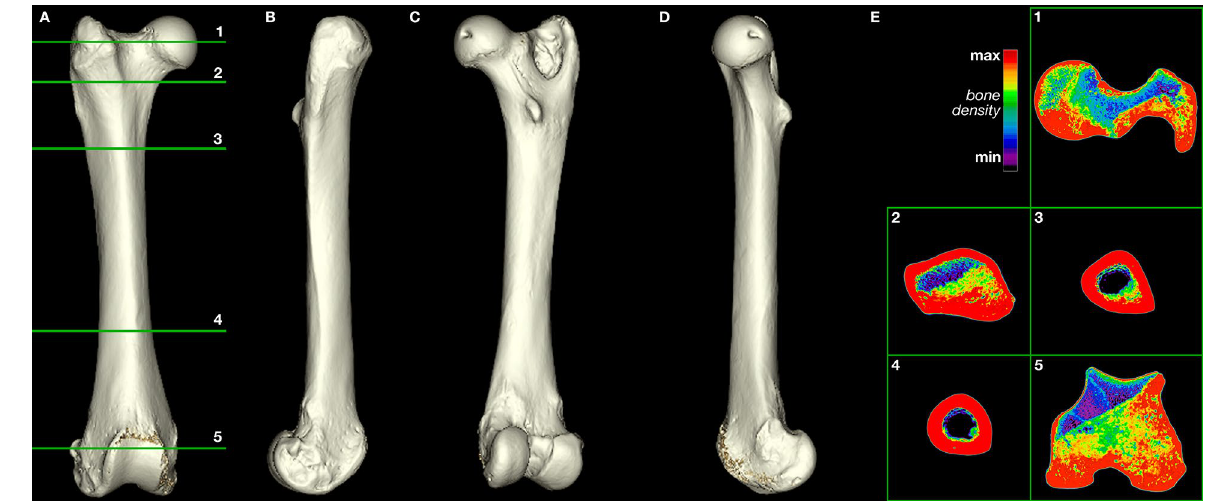
Figure 5. Three-dimensional model of a normal Smilodon right femur (LACMHC K-3232). Horizontal numbered lines in ( A ) mark anatomical location of numbered CT slices displayed in ( E ). ( A ) Anterior view of right femur; ( B ) rotated 90 degrees from anterior about the vertical axis (lateral view); ( C ) rotated 180 degrees from anterior about the vertical axis (posterior view); ( D ) rotated 270 degrees from anterior about the vertical axis, displaying the femoral head and neck (medial view). ( E ) 0.63 mm axial CT images of the normal right femur corresponding with the three-dimensional model. Each inset image has been flipped and rotated so that top corresponds to anterior, right corresponds to anatomical right, bottom corresponds to posterior, and left corresponds to anatomical left sides. Model created using Mimics version 20.0 (https:// www. mater ialise. com/ en/ medic al/ mimics- innov ation- suite/ mimics).